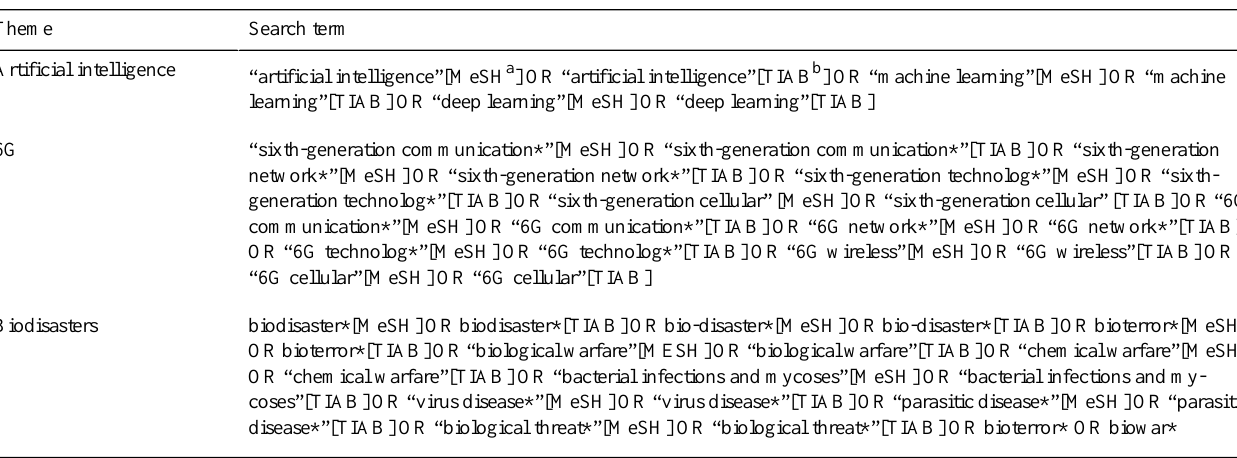
Table 1. Search terms used on PubMed.